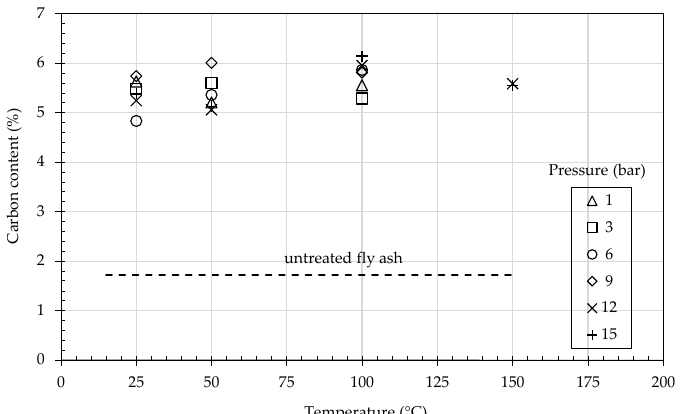
Figure 1. X-ray diffraction pattern of fly ash.